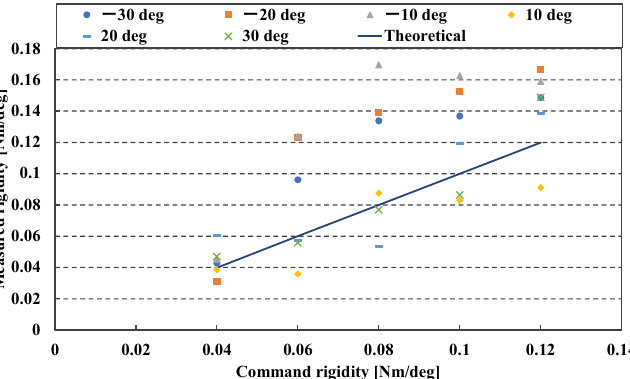
Figure 7. Measurement results of joint angles. In this graph, the vertical axis represents the meas- ured angle, and the horizontal axis represents the target angle.